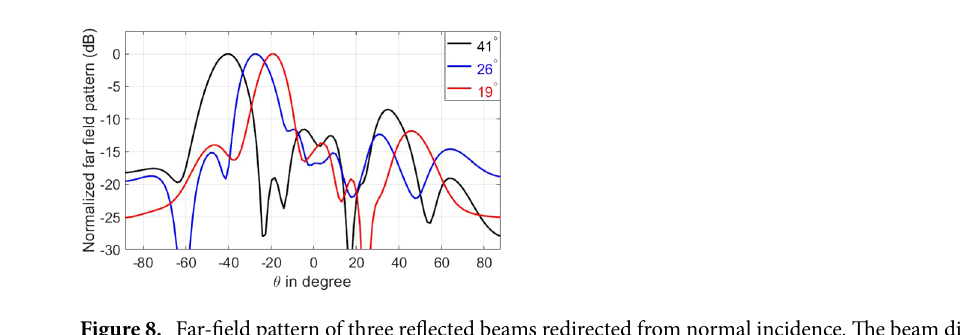
Figure 8. Far-field pattern of three reflected beams redirected from normal incidence. The beam direction is measured with reference to the normal to the